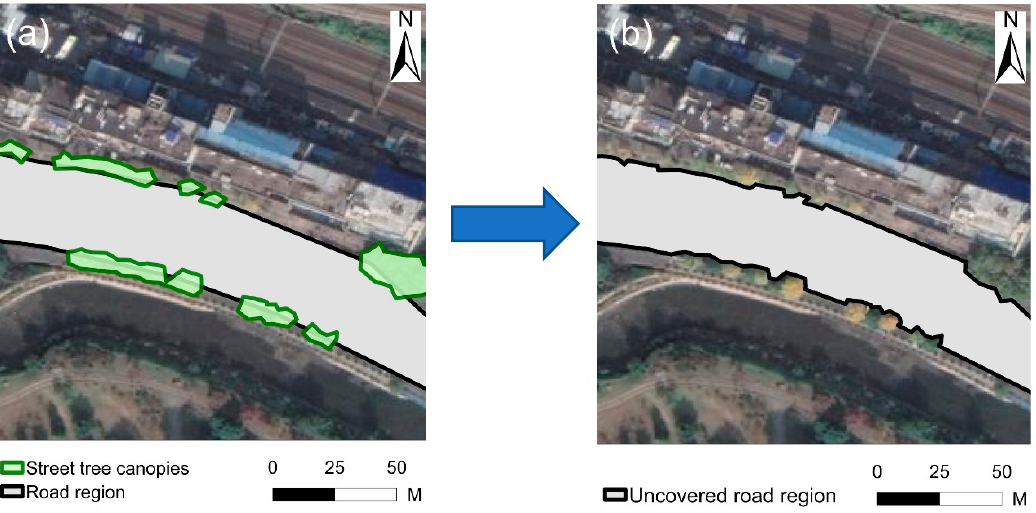
Figure 7. Extraction process illustration of uncovered road region: ( a ) extracted road region and street tree canopies; ( b ) uncovered road region.